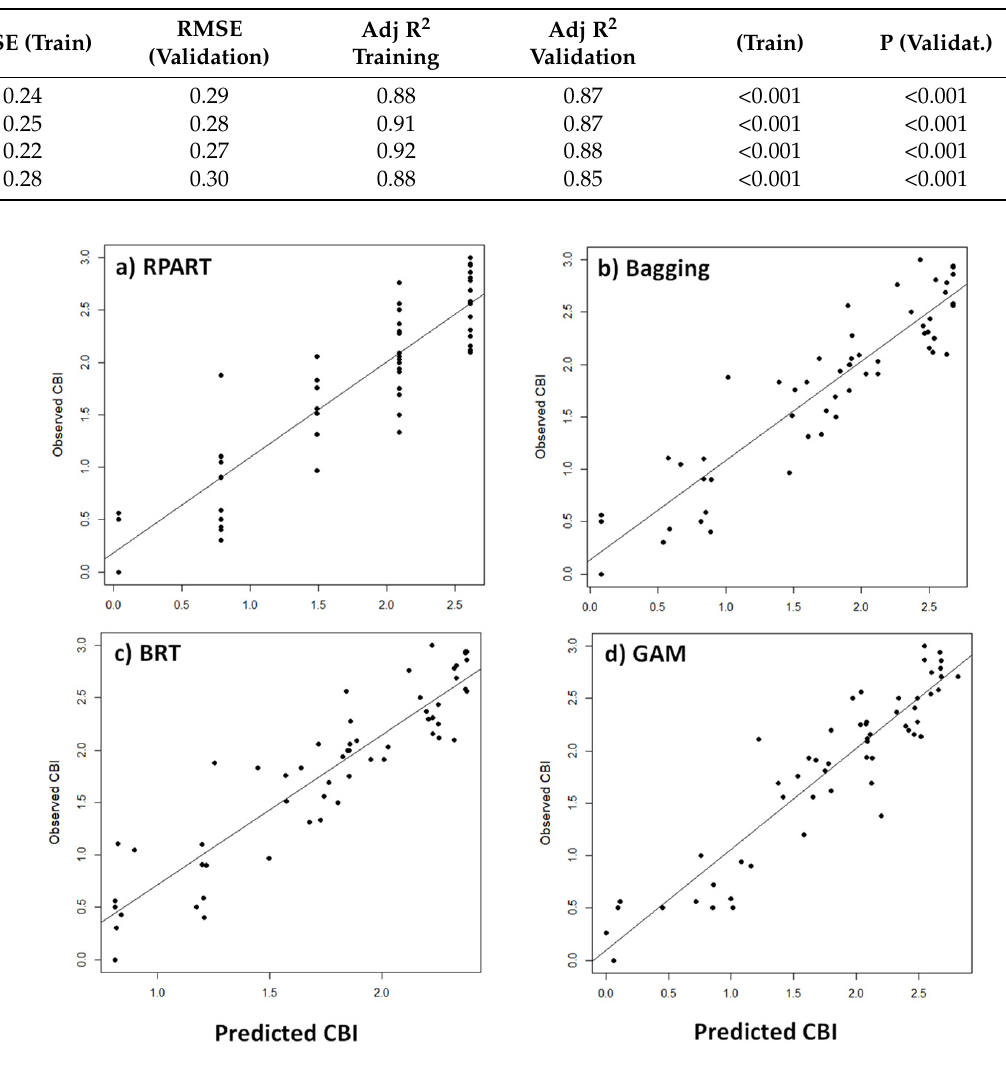
Figure 5. Partial dependence of CBI on the spectral severity indices used as explanatory variables from: ( a ) the regression tree (RPART); ( b ) the bagging; ( c ) the boosted regression tree (BRT); and ( d ) generalized additive (GAM) models using training data (n = 135). Here, it is shown only the signif- icant spectral severity indices (RBR, dNBR, and dTAI).